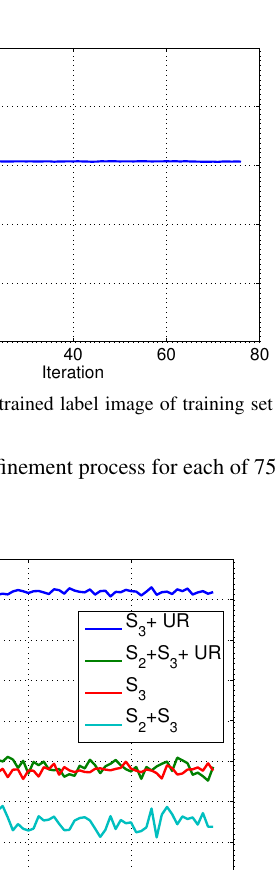
(b) Number of support vectors per class (class is colour coded) of training set T02 for each iteration with magnification of im- portant section.